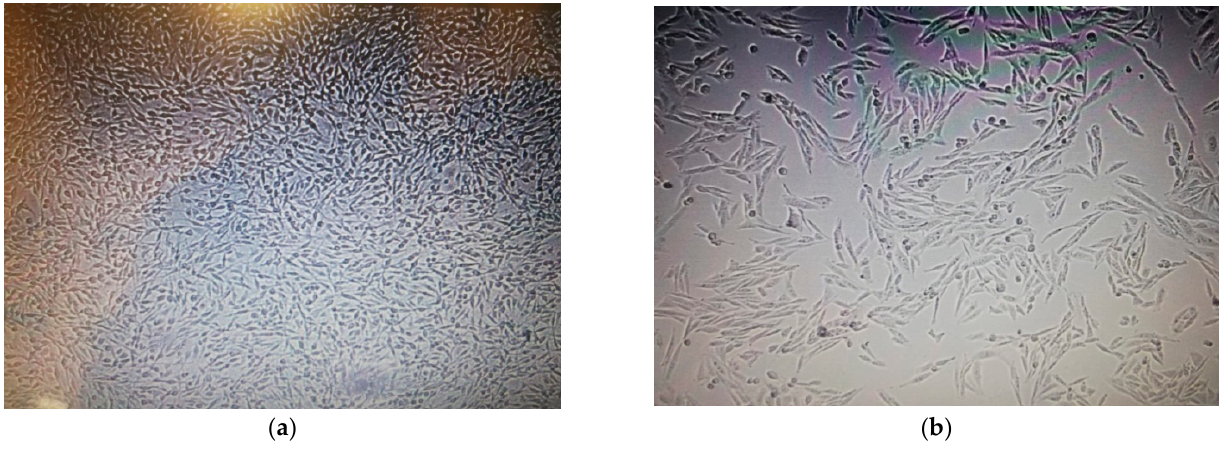
Figure 6. ( a ) Microscopic image of MCF-7 cells after 72 h. MCF-7 cells are well developed and confluent. ( b ) Microscopic image of MCF-7 cells after exposure to NP dosing. Reduced cell viability and less confluence are apparent after dosing.